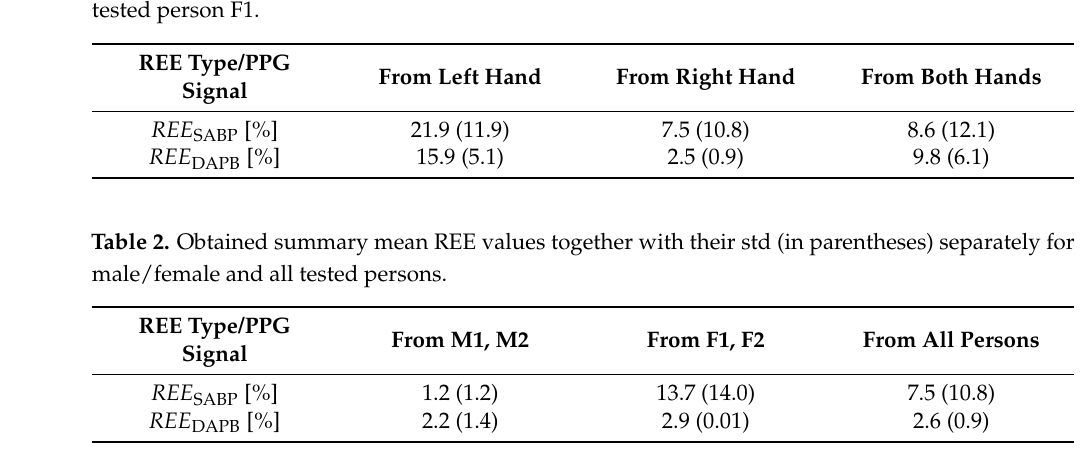
Figure 4. Histograms of occurrence distributions of time PPG WF parameters (from left to right): ta2/Tpp ratio, tb2/Tpp ratio, t2/Tpp, and t3/Tpp ratio; PPG signals from both hands of a person M1. Table 1. Obtained partial mean REE values together with their std (in parentheses) separately calculated for the left hand, the right hand, and both hands together; PPG signals sensed from the tested person F1.